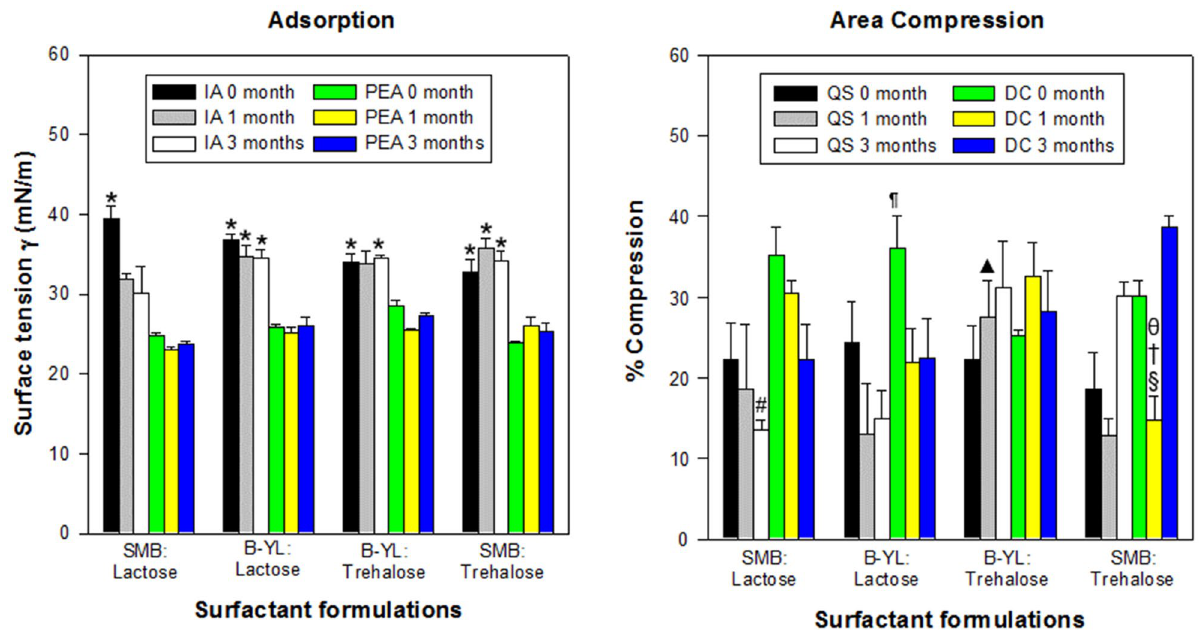
Figure 4. Mean ± SEM adsorption and area compression values of the four dry powder surfactant formulations from the 2nd series. Formulations contained 70% phospholipids with a DPPC:POPG ratio of 7:3, Super Mini-B (SMB) or B-YL as surfactant peptide and lactose or trehalose as excipient. Surfactant formulations were tested at baseline (0 month) and after 1 and 3 months of exposure to 40 0 C and 75% relative humidity (1 month and 3 months). The left-sided figure depicts initial adsorption (IA) and post-expansion adsorption (PEA) expressed as surface tension in mN/m. The right-sided figure shows % compression necessary to reach minimum surface tension during quasi-static (QS) and dynamic cycling (DC) at 0, 1 and 3 months of exposure to 40 °C and 75% relative humidity. *p < 0.001 for IA vs corresponding PEA values.; # p < 0.05 for QS 3 months of SMB: Lactose vs B-YL: Trehalose and SMB: Trehalose; ▲ p = 0.012 for QS 1 month of B-YL: Trehalose vs SMB: Trehalose; § p < 0.0001 for QS 1 month of SMB: Trehalose vs QS 3 months of SMB: Trehalose; ¶ p = 0.0254 for DC 0 month of B-YL: Lactose vs B-YL: Trehalose; † p < 0.004 for DC 1 month of SMB: Trehalose vs B-YL:T rehalose and SMB: Lactose; θ p < 0.004 for DC 1 month vs DC 0 and 3 months of SMB-Trehalose. See Table 1 for details on composition of the